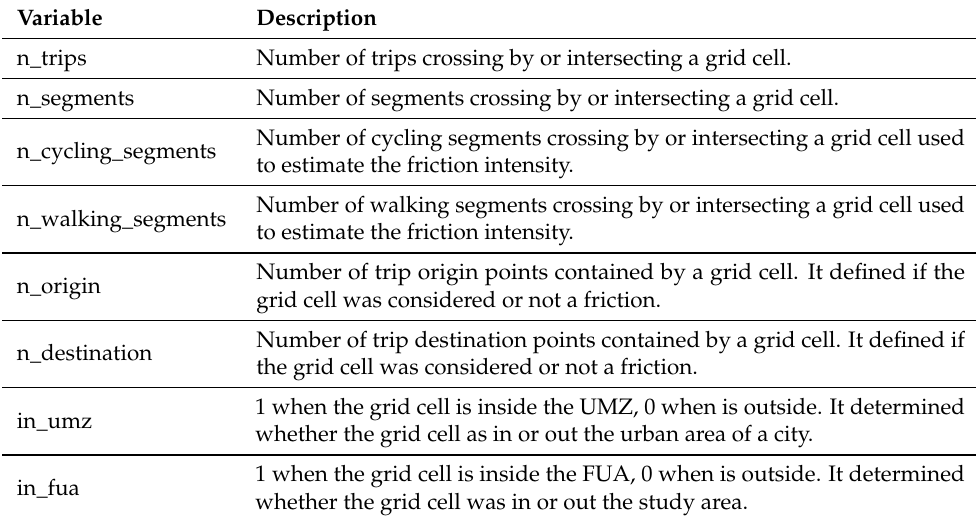
Table 2. Variables calculated during the